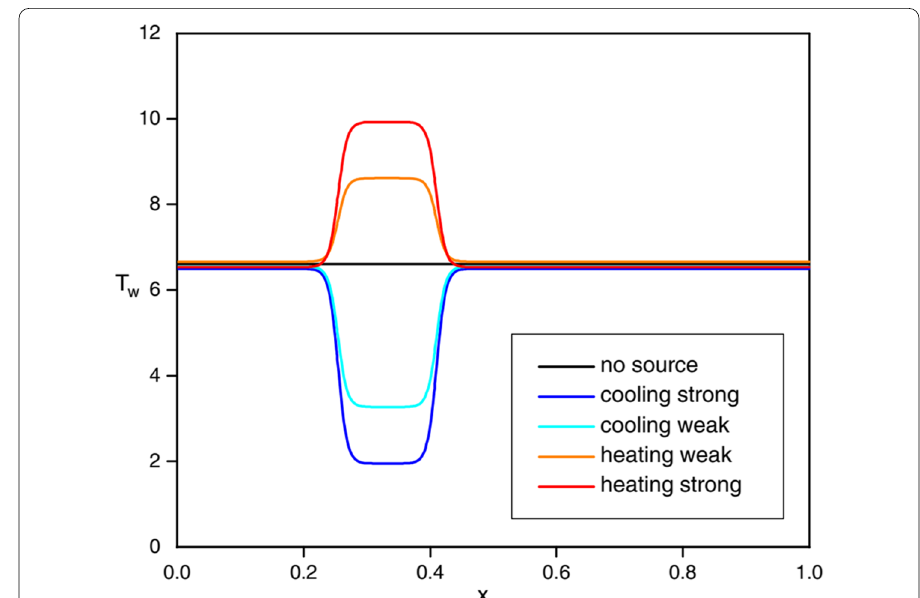
Fig. 18 Wall temperature distributions for the cases given in Ref.